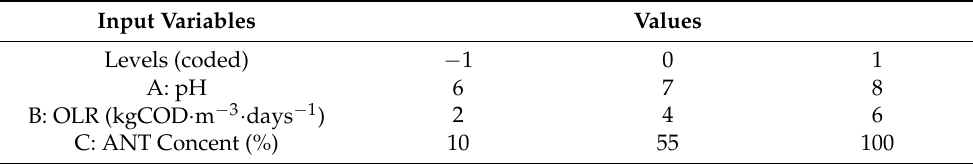
Table 6. Experimental range and levels of the independent